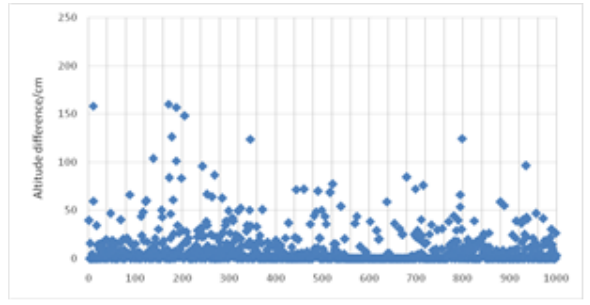
Figure 6. Altitude difference distribution